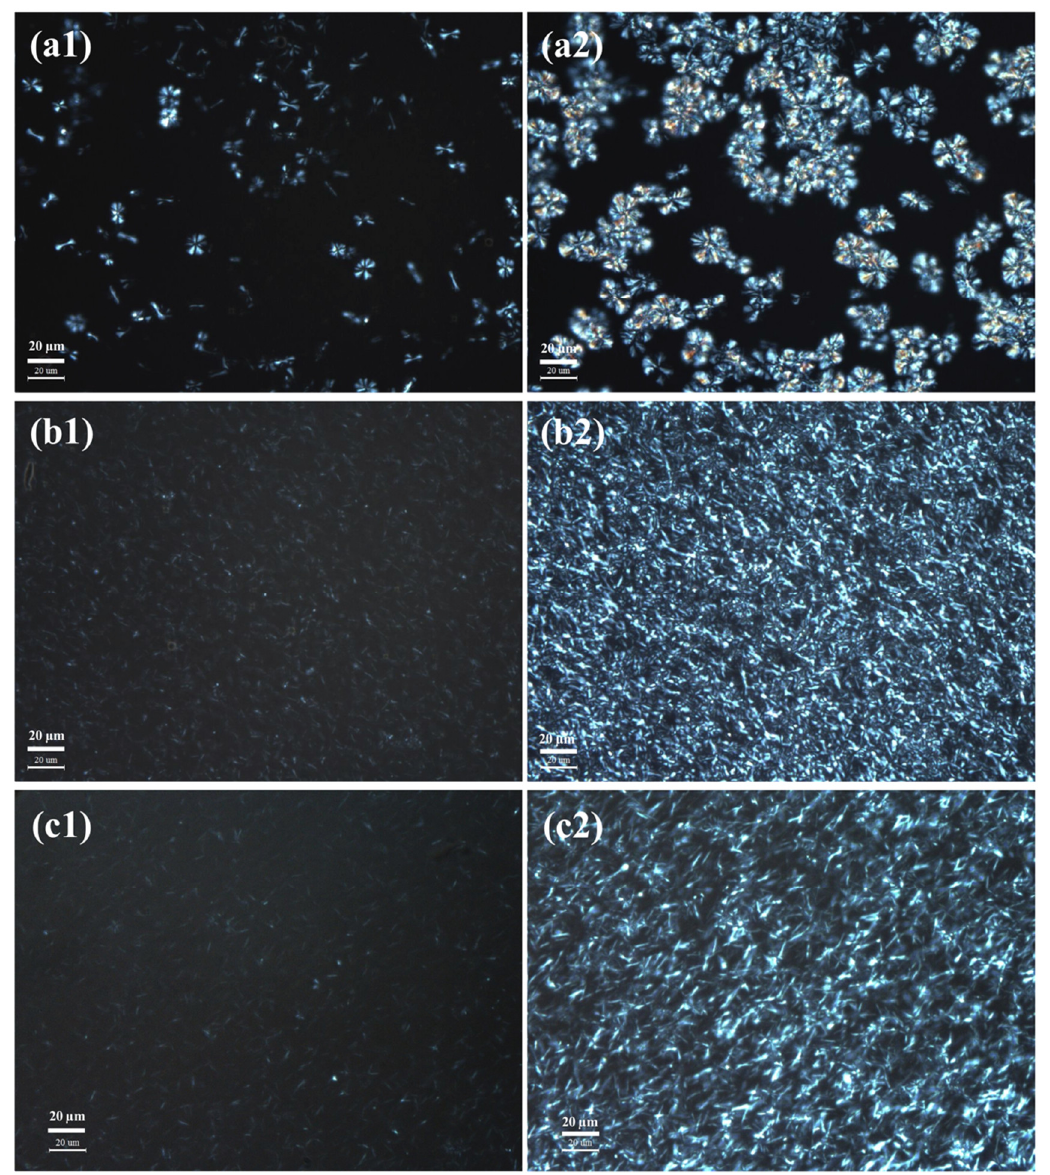
Figure 3. The POM pictures of isothermal crystallization of ( a1 , a2 ) MXD6, ( b1 , b2 ) MXD6/P22, ( c1 , c2 ) MXD6/DT/P22 at 216, 220 and 213 °C at 5 and 10 min, respectively.